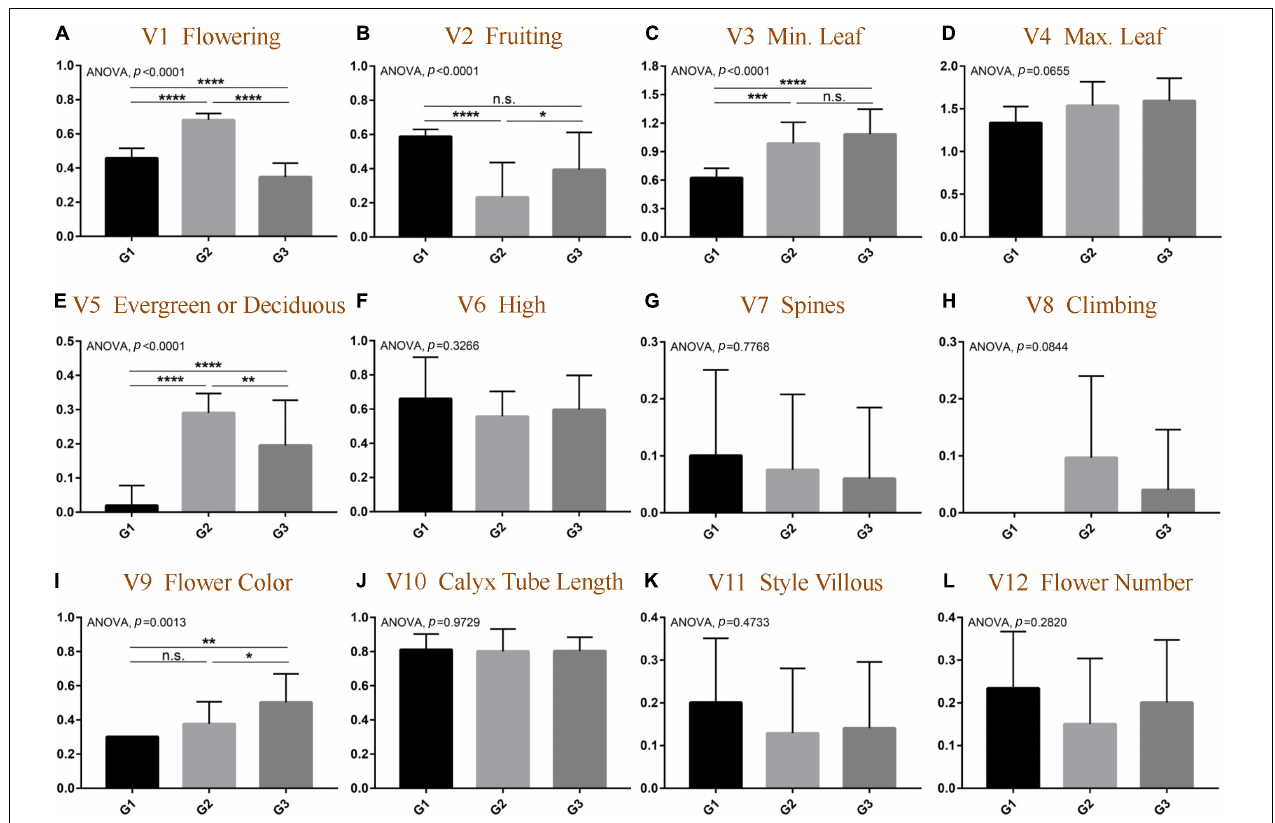
FIGURE 3 | Comparative analysis of morphological differentiation at quantitative traits among different groups of genus Elaeagnus . (A) Flowering (V1); (B) Fruiting (V2); (C) Minimum leaf size (V3); (D) Maximum leaf size (V4); (E) Evergreen or deciduous (V5); (F) Plant height (V6); (G) Spines or absent (V7); (H) Climbing or not (V8); (I) Flower color (V9); (J) The length of calyx tube (V10); (K) Style villous (V11); and (L) the flower number (V12). ( N > 9; t -test, **** p < 0.0001; *** p < 0.001; ** p < 0.01; and * p <